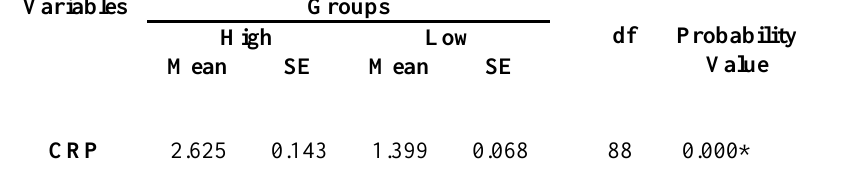
Table 4: Salivary C-Reactive protein in ml/min according to depression grade Variables Groups